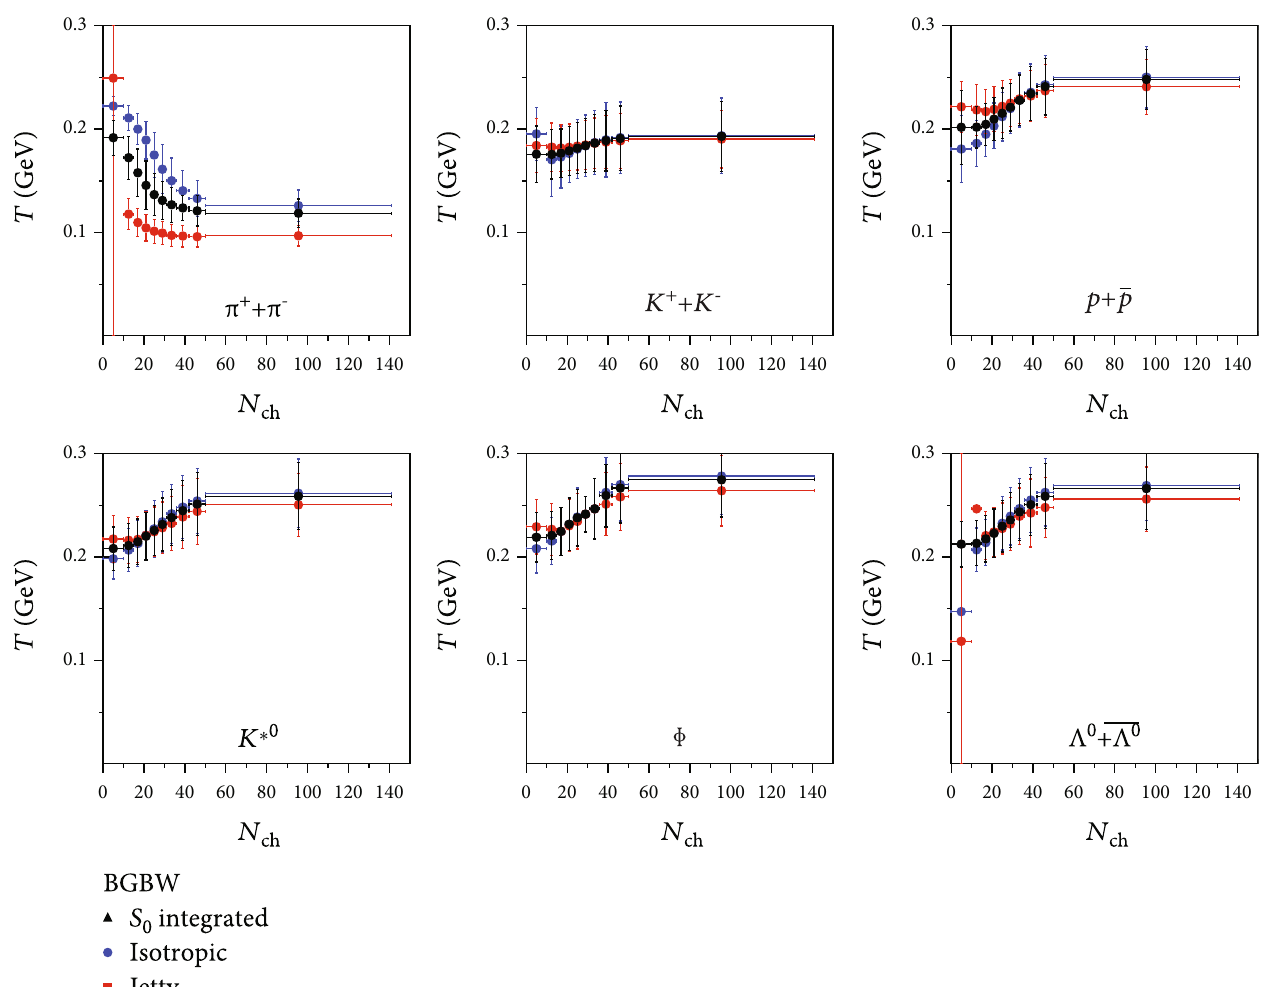
Figure 15: (Color online) Multiplicity dependence of T in di ff erent spherocity classes from the fi tting of the BGBW